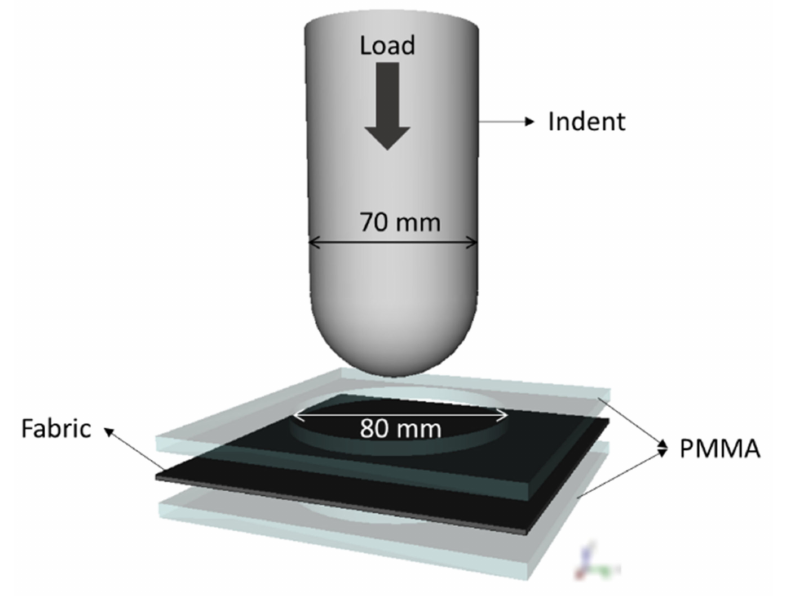
Figure 2. Drapability device (based on Ref.